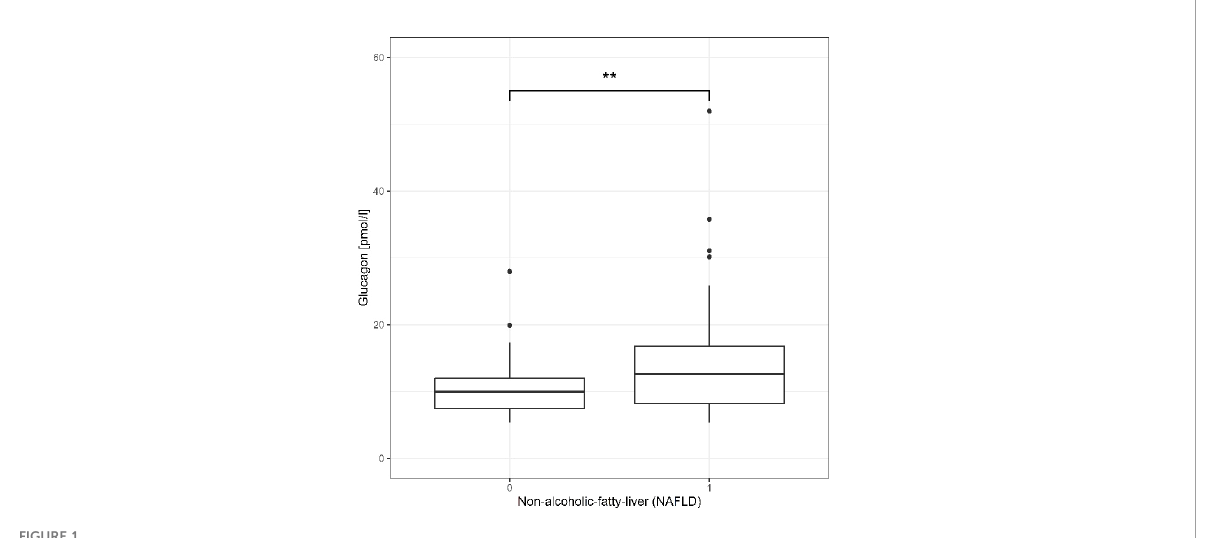
FIGURE 1 Fasting glucagon concentration pmol/L of participant without NAFLD (0, n = 66) and with NAFLD (1, n = 66) are shown a box plot in quartile and outliers. Wilcoxon test yielded a highly signi fi cant result p=0.0079 a **p < 0.01.